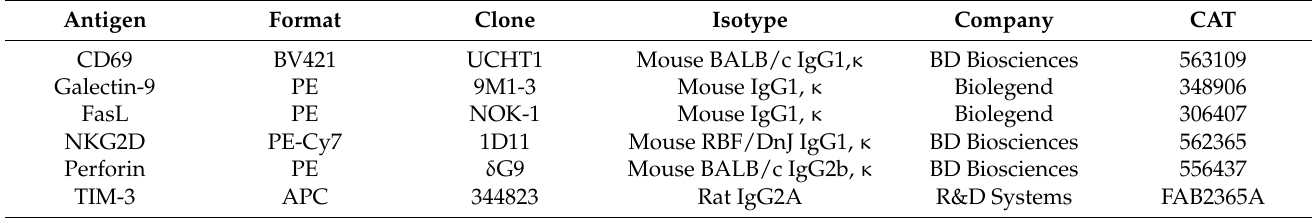
Table 1. Fluorochrome-conjugated monoclonal antibodies used in the